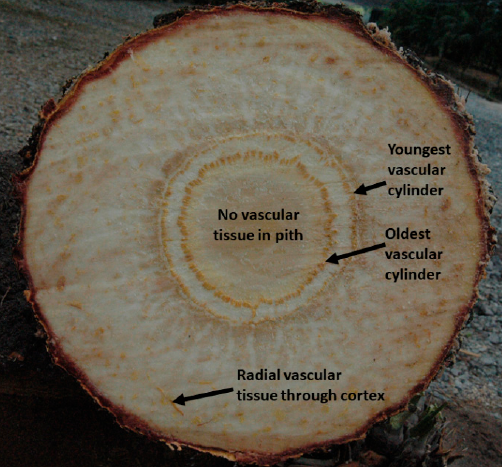
Figure 1. Arborescent cycad plant stems are comprised of central persistent parenchymatous pith, concentric vascular cylinders that connect roots to stem apex, and persistent peripheral parenchymatous cortex. Radial vascular stands pass through cortex to connect the vascular cylinders to leaves. This vascular tissue persists in the cortex after leaf senescence.